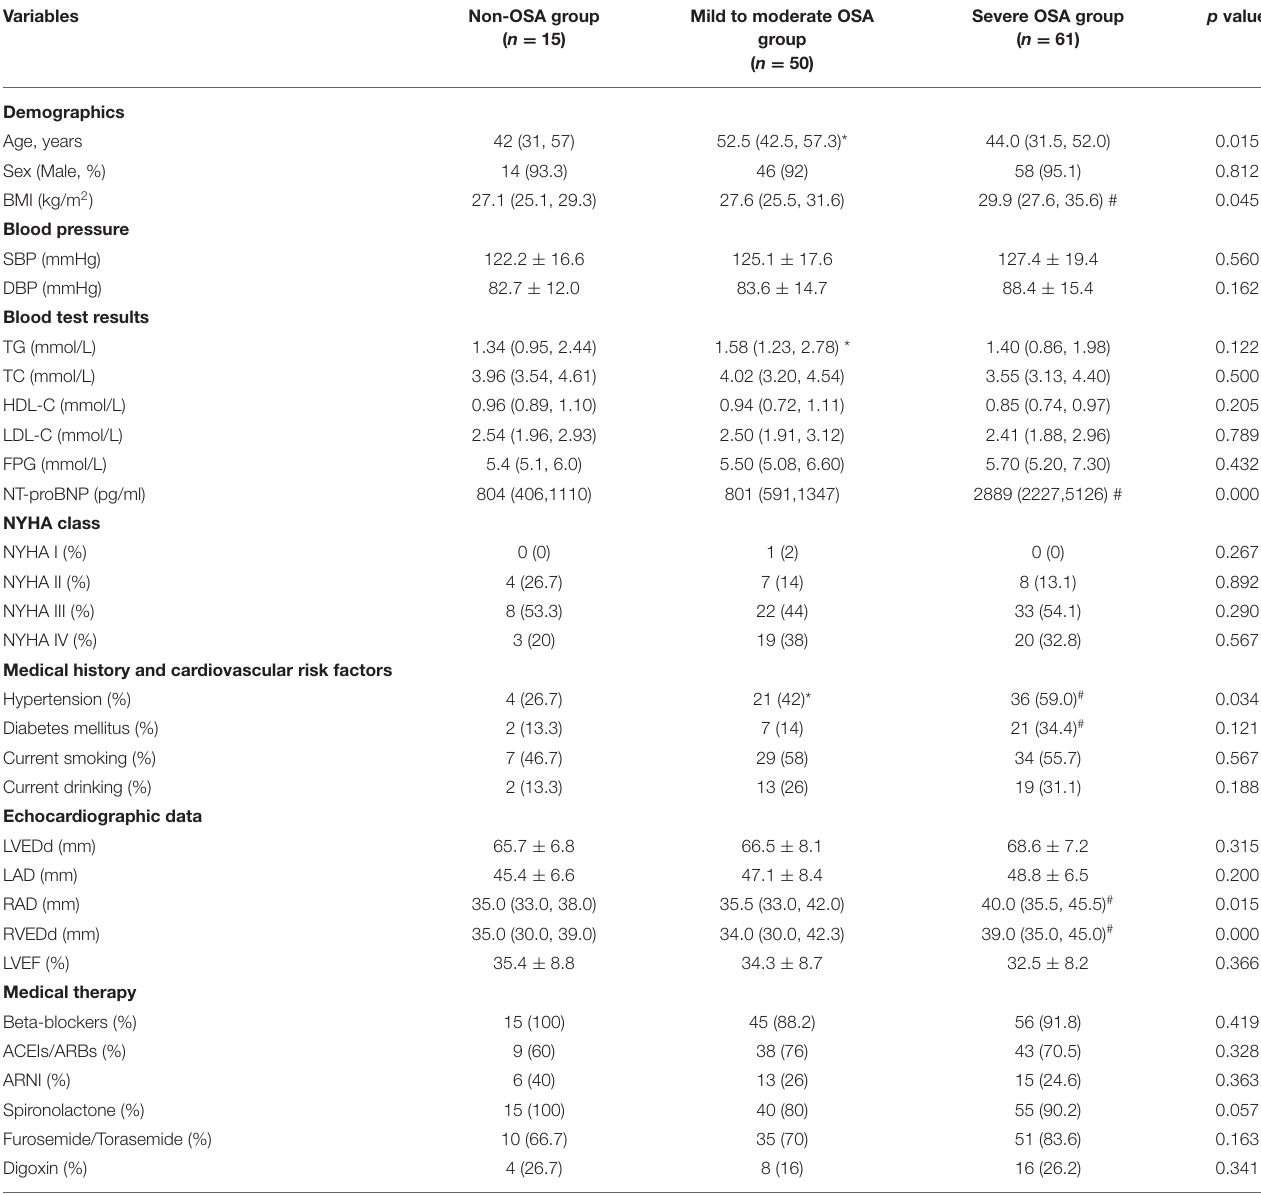
TABLE 1 | Baseline characteristic, echocardiographic data, and medical therapy of all patients. Variables